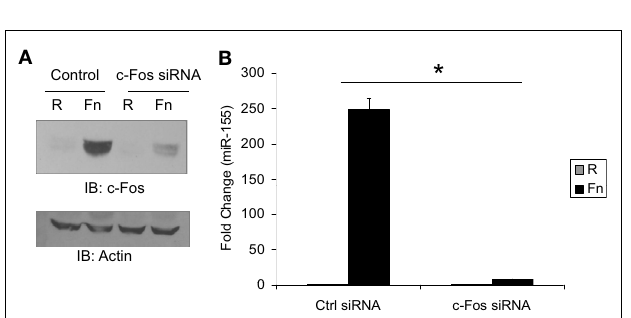
FIGURE 5 | Fos and Jun expression is highly up-regulated by infection in an NF- κ B-dependent mechanism to controlAP-1 activity. (A) PBM were pre-treated with DMSO or BAY-11-7085 (5 μ M; designated as BAY in the figure) for 30min then infected with F.n. at an MOI of 50 for 4h. Cells were lysed and subject to western blotting for c-Fos, followed by actin re-probe. (B) Protein-matched lysates were probed for c-Jun and re-probed with actin antibody. (C) RAW264.7 macrophages were transfected with an AP-1 luciferase reporter. 14h post-transfection cells were uninfected or infected